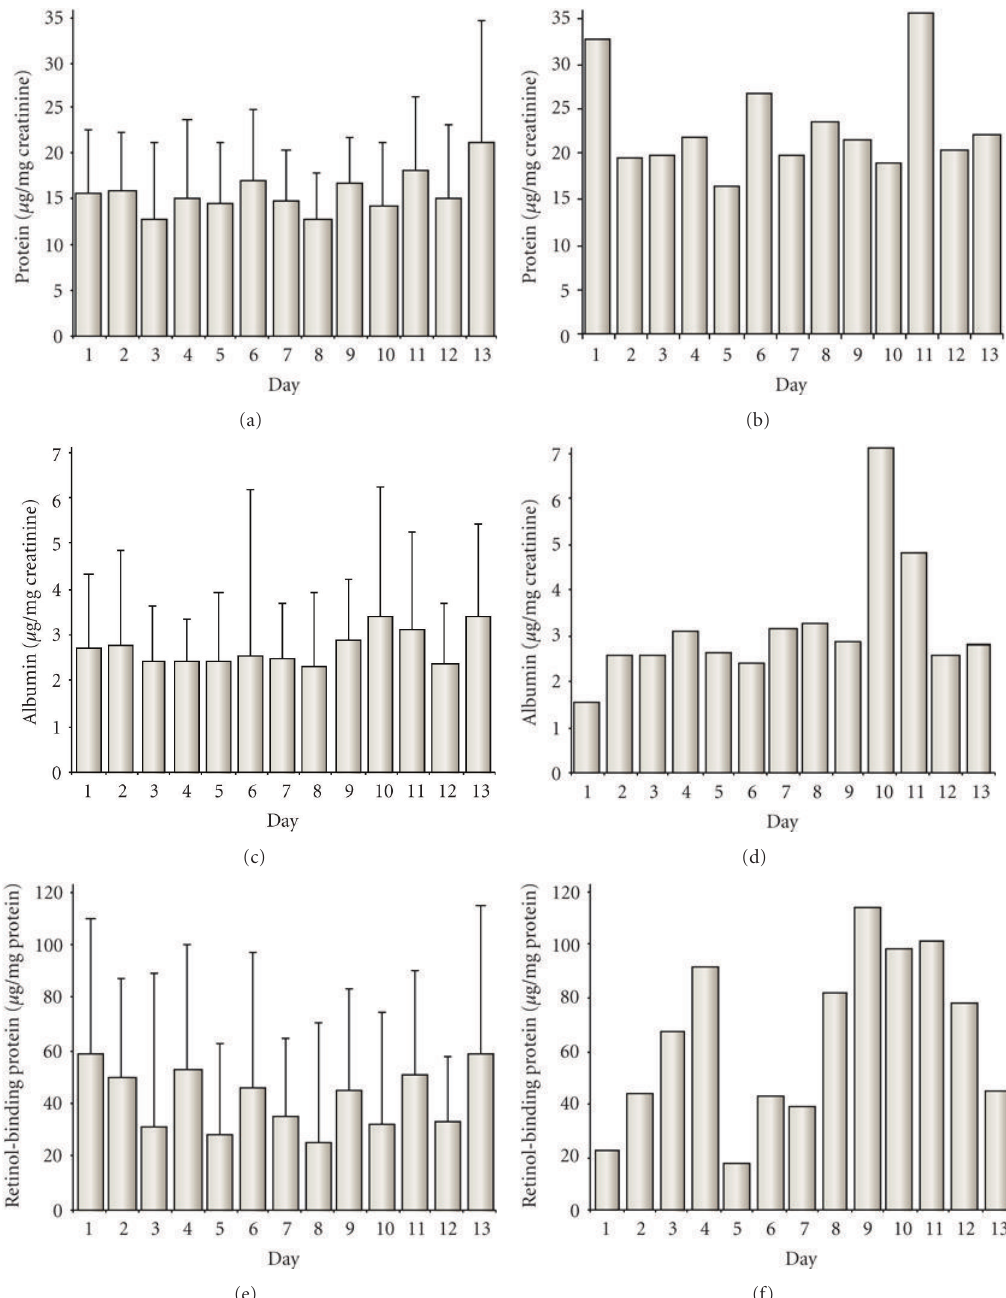
Figure 2: Quantification of proteins (a, b), microalbuminuria (c, d), and retinol binding protein (e, f) in urine. (a, c, e): mean values (and SD) of the urinary protein content of di ff erent volunteers and di ff erent treatment periods. (b, d, f): Urinary protein content of one representative volunteer during one-treatment